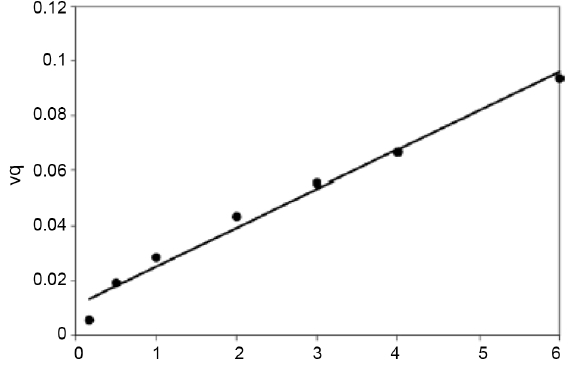
Fig. 3. A plot of t / q vs. time according to the pseudo-second order adsorption kinetics